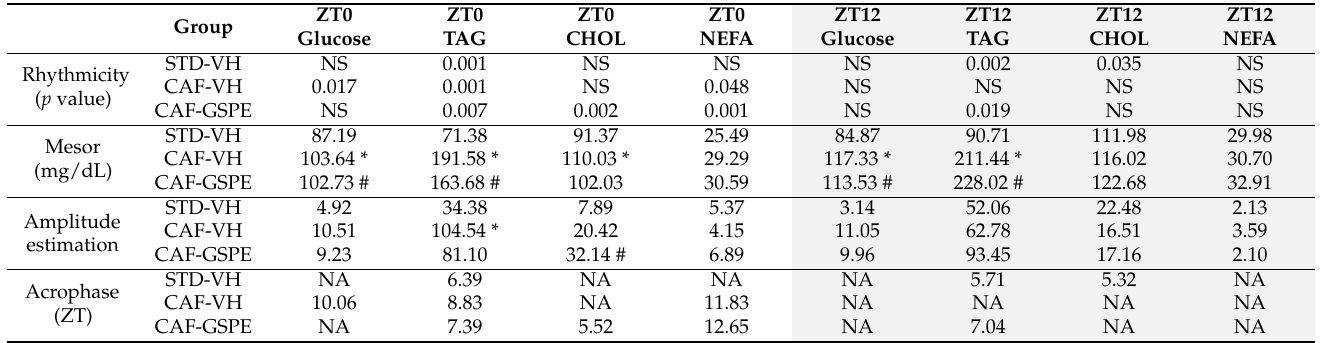
Table 2. Rhythm variables of main metabolic parameters in serum of rats fed standard or cafeteria diet treated with vehicle or GSPE at ZT0 or ZT12.